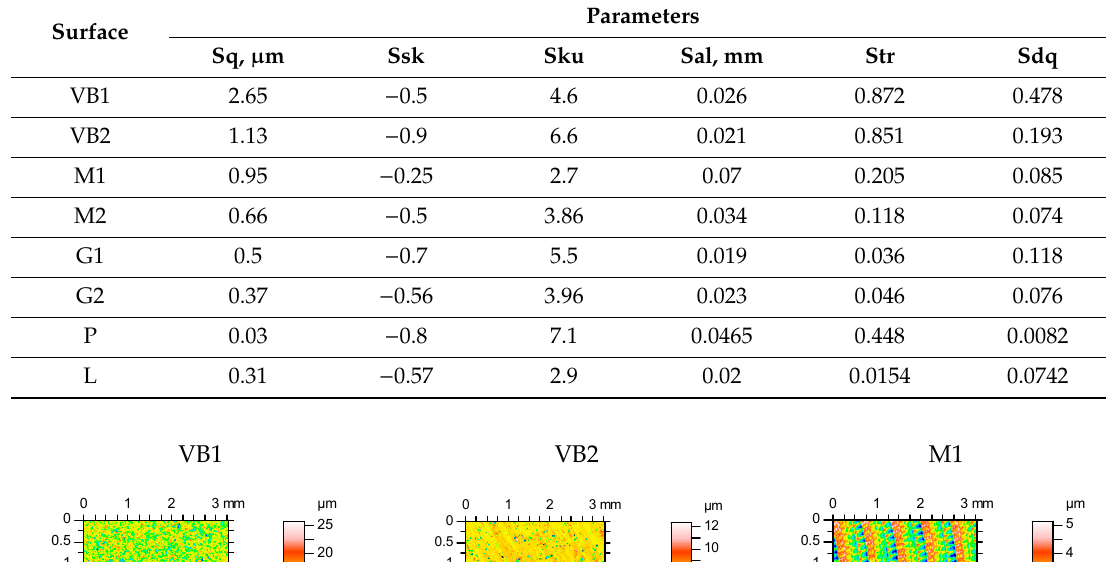
Table 2. Parameters of surface topographies of discs: Sq, Ssk, Sku, Sal, Str and Sdq before fretting tests.